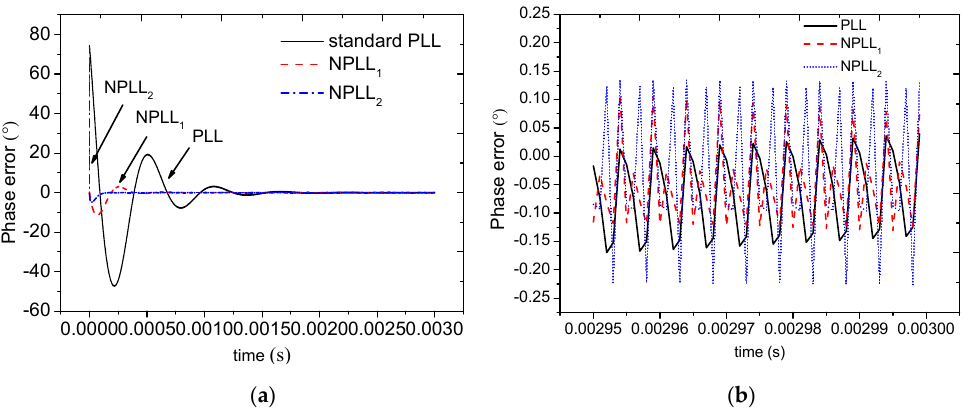
Figure 8. Phase error of PLL under no frequency offset: ( a ) phase error of PLL under no frequency offset; ( b ) phase error of PLL after 2.95 ms. offset; ( b ) phase error of PLL after 2.95 ms.